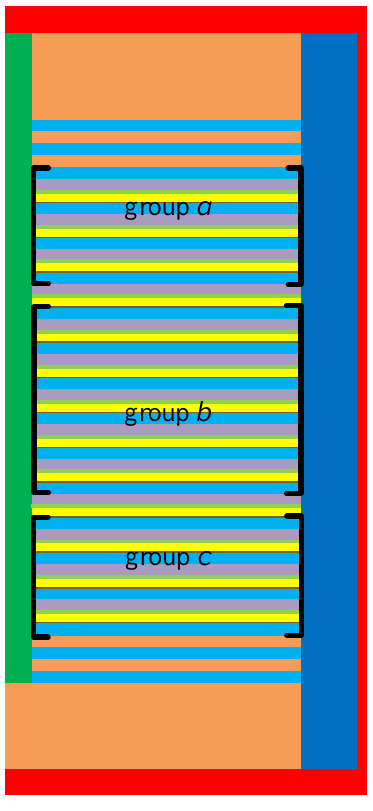
Figure 4. Sketch of the heat pellet group.